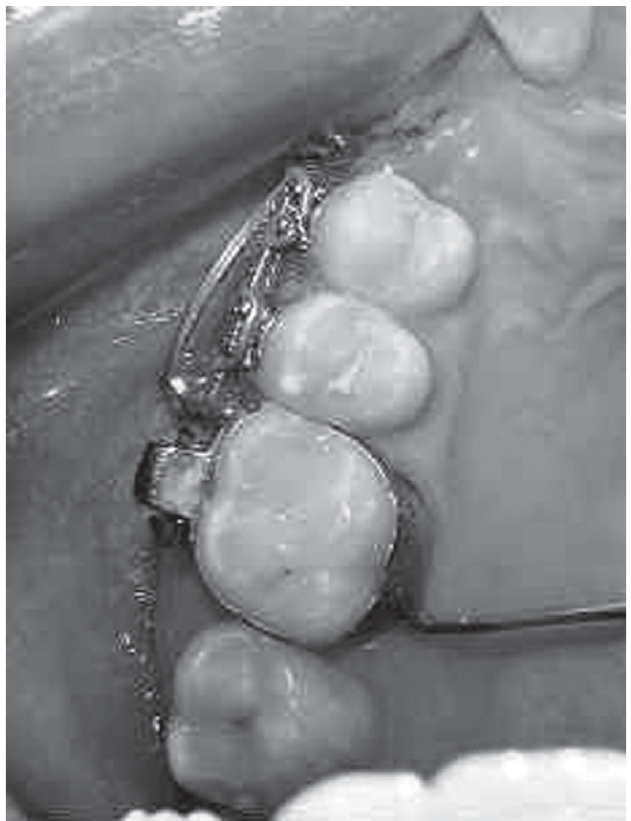
Fig. 9: Occlusal photograph of cantilever